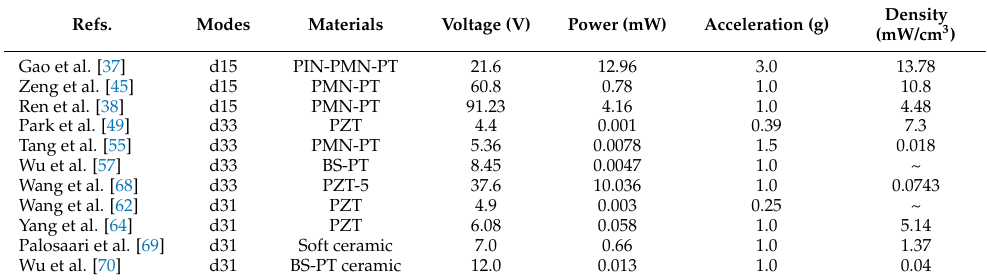
Table 1. Comparison of the characteristics of several typical piezoelectric operating mechanisms.